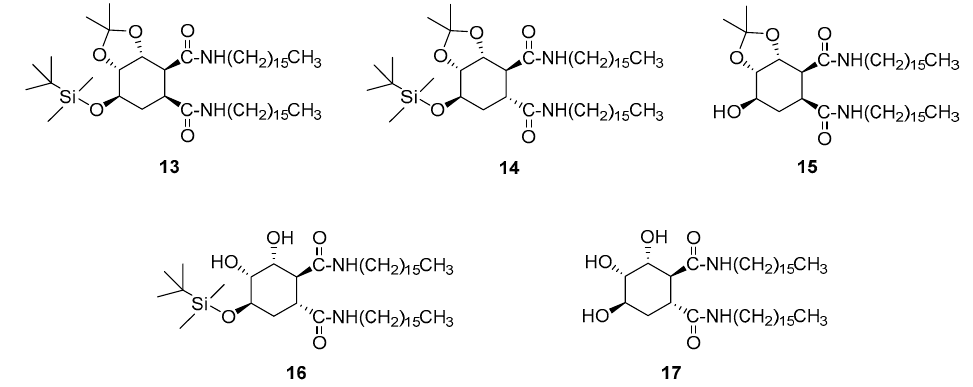
Figure 9. Polyfunctionalized cyclohexane-based bisamide organogelators.